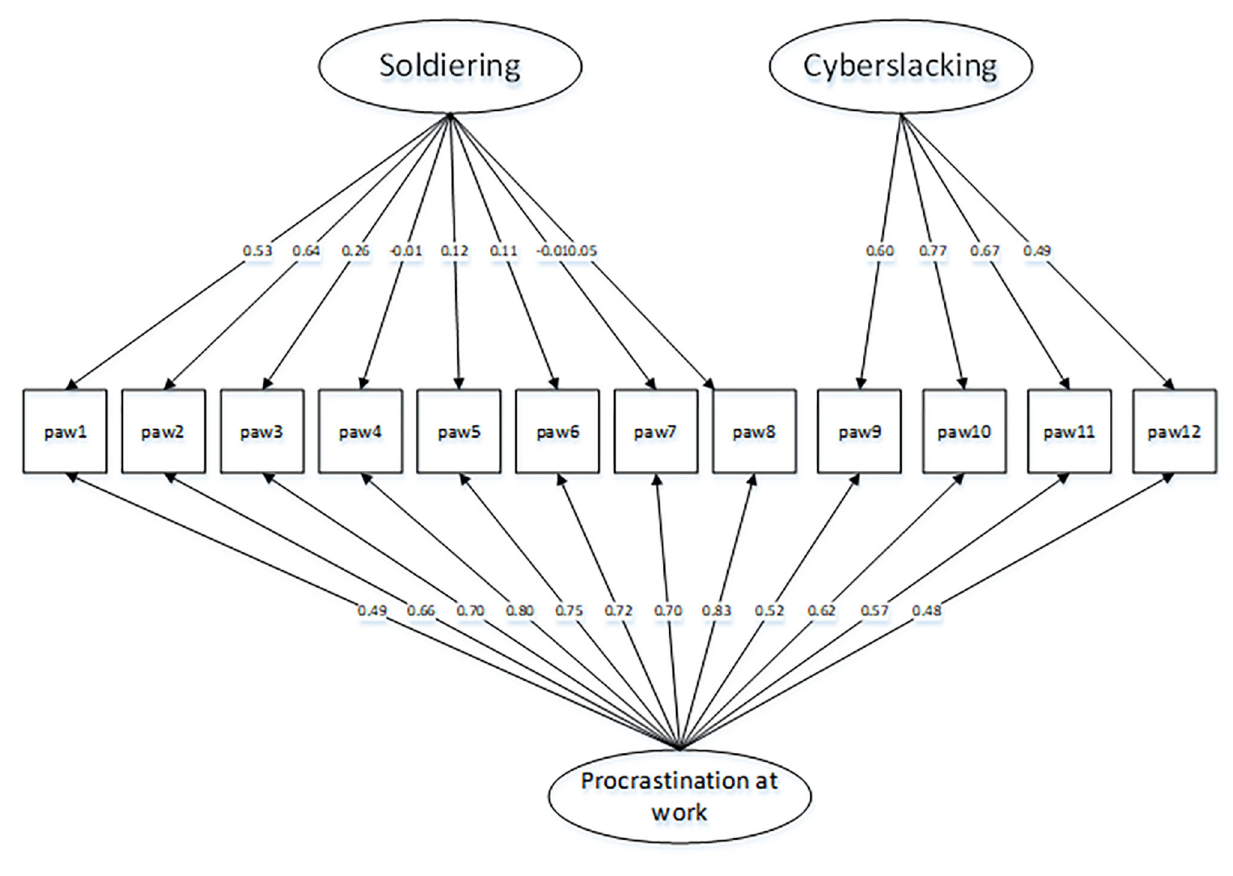
99.57, p < 0.001]; CFI, Comparative Fit Index =